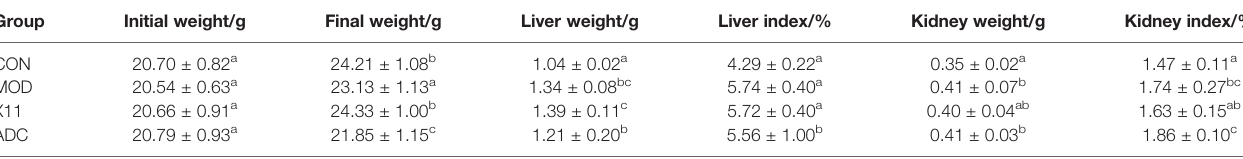
TABLE 3 | Effects of Lactobacillus paracasei X11 on body weight, organ coef fi cient in hyperuricemia mice.